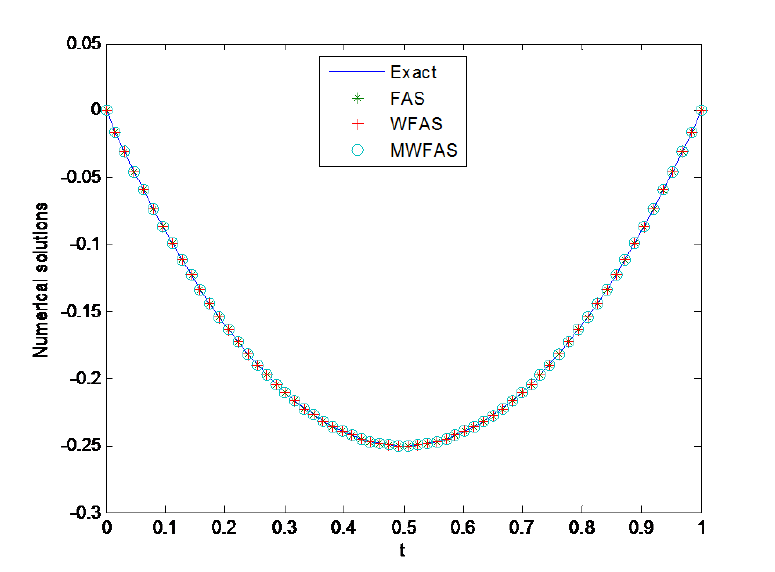
Fig. 4 Comparison of numerical solutions with exact solution of test problem 5.4, for N